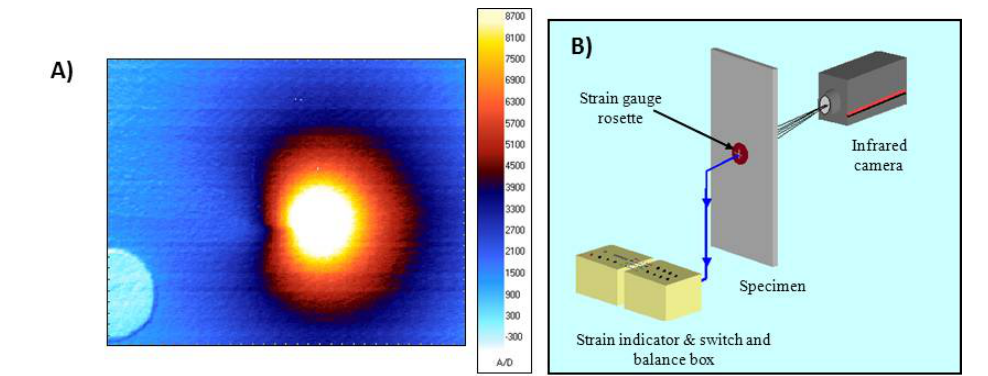
Figure 1: A) Typical thermoelastic pattern of a fatigue crack. B) Schematic illustration of the calibration process.